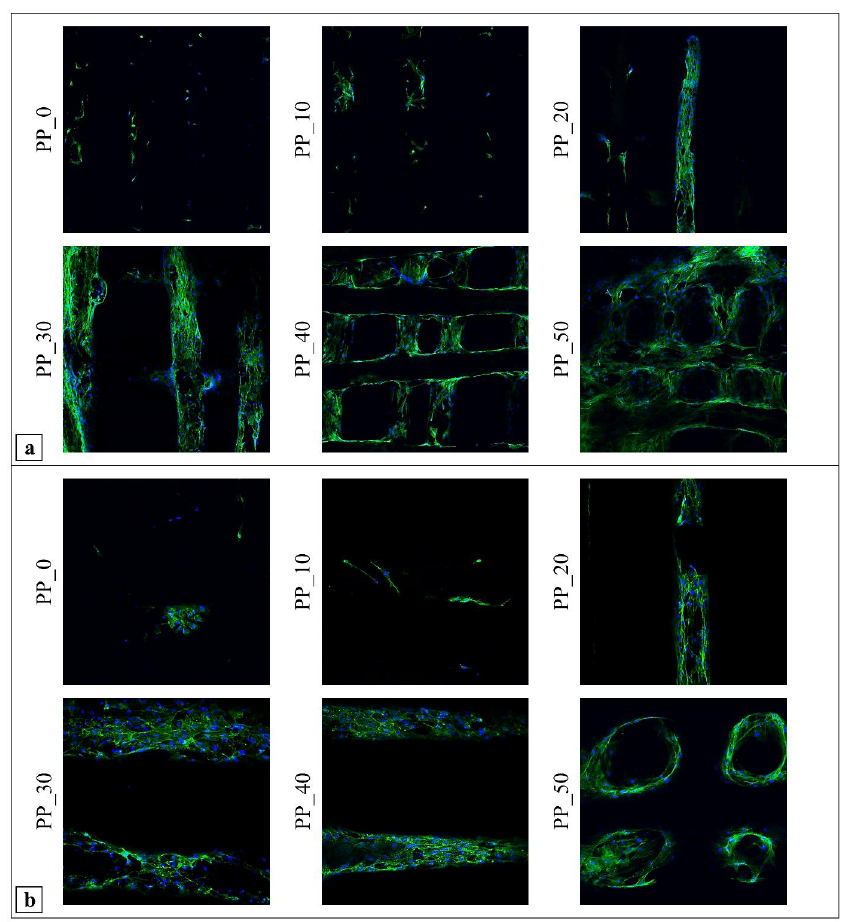
Figure 9. CLSM micrographs showing MC3T3-E1 cells after 28 days of culture on scaffolds with varied PHBV/PLGA weight ratios (PP_0, PP_10, PP_20, PP_30, PP_40, PP_50) taken at different magnifications, ( a ) 10×, ( b ) 20×, highlighting differences in cell colonization by changing the blend composition (cytoskeleton stained with Alexa Fluor 488 phalloidin demonstrating green fluorescence; nuclei stained with blue-emitting fluorescent DAPI).